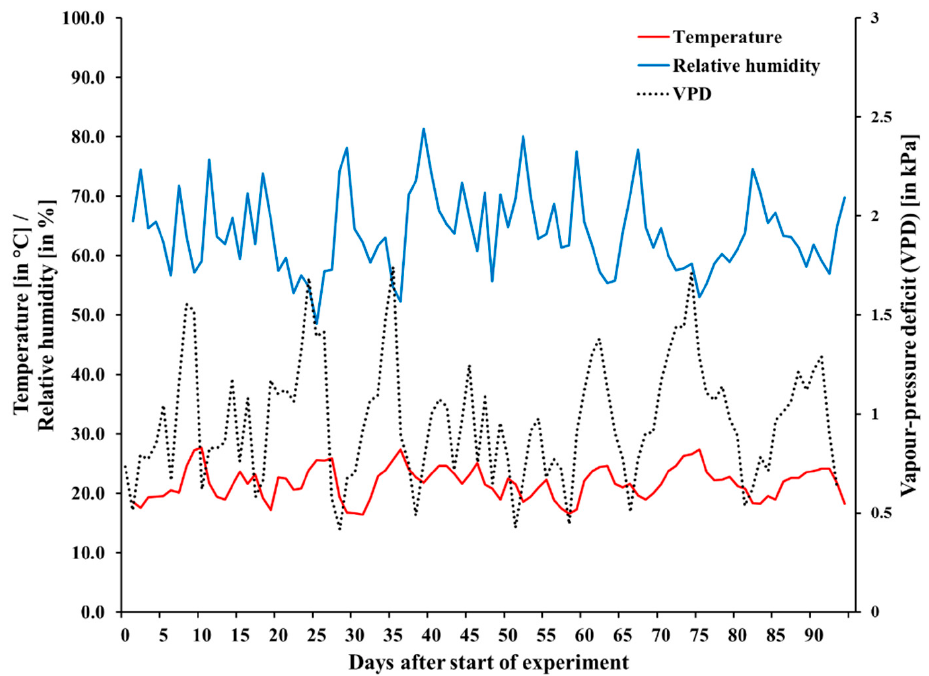
Figure 1. Daily mean values of air temperature, air humidity, and vapour pressure deficit in the open greenhouse during the experimental period (fruit set to harvest) in 2016.